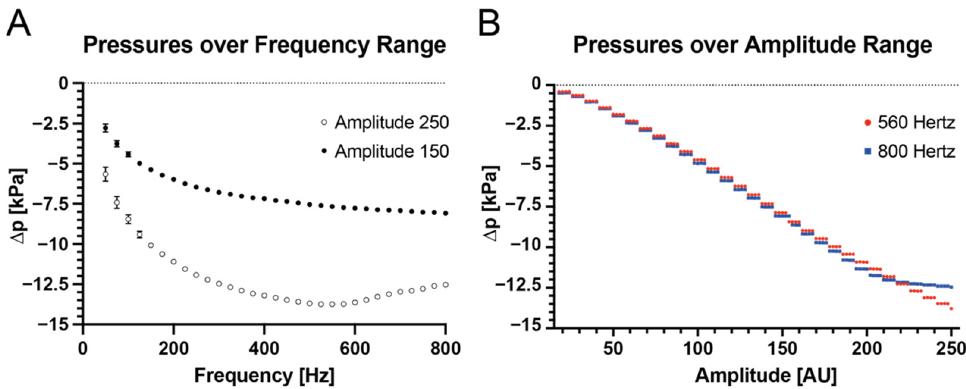
Figure 2. Pump characterization. ( A ) Micropump pressure outputs at fixed amplitudes (150 and 250 AU) for varying frequencies and ( B ) Micropump pressure output at fixed frequencies (560 and 800 Hz) for varying amplitudes. The maximum pressure output was achieved at an amplitude of 250 and between 525 and 575 Hz.